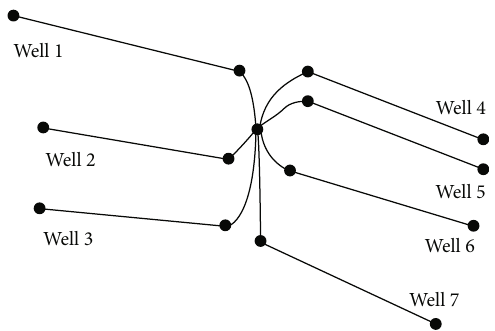
Figure 1: Well pad schematic. Seven MFHWs drilled in the southern Sichuan